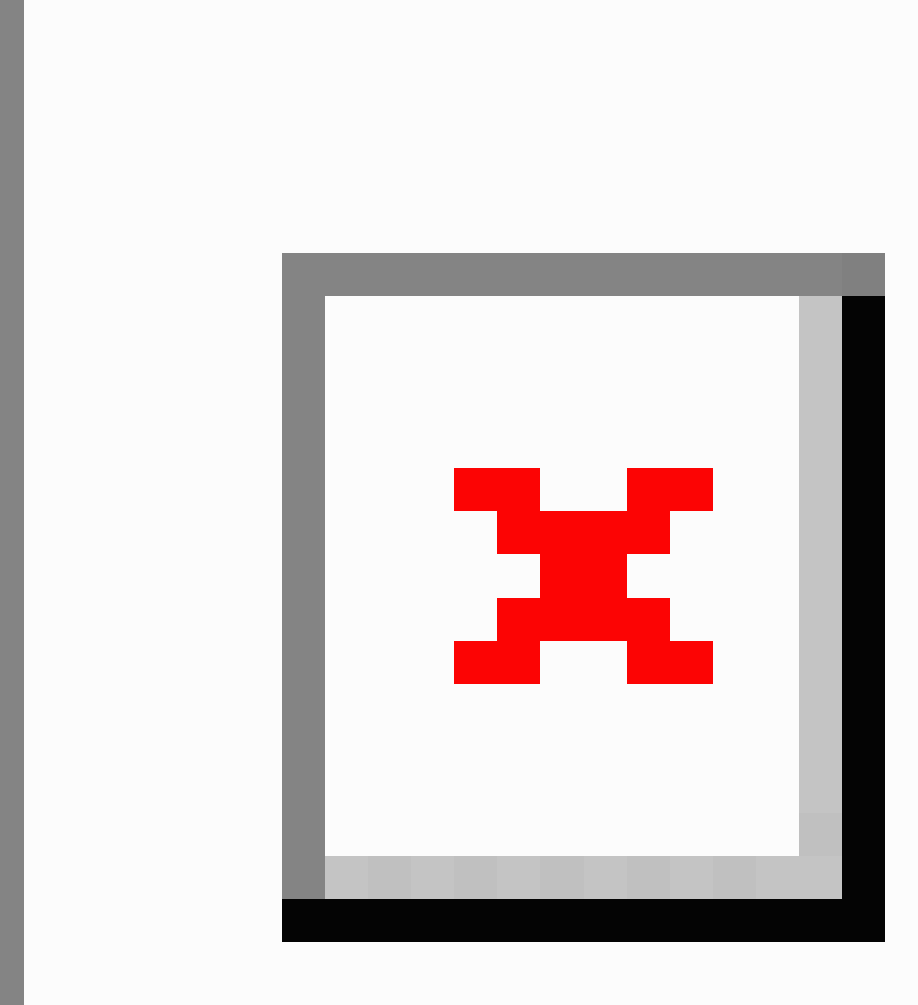
Figure 1. Participant